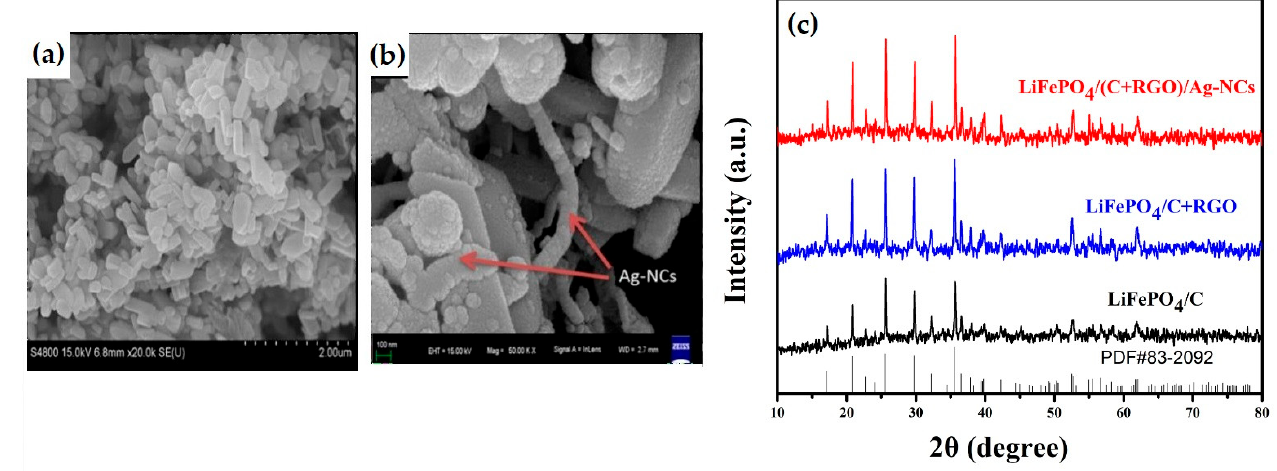
Figure 5. SEM images of LiFePO 4 /C ( a ) and LiFePO 4 /(C + rGO)/Ag-nanochains ( b ) and their XRD patterns ( c ) [61]. Table 3. Comparison of synthetic processes during hydrothermal conditions.